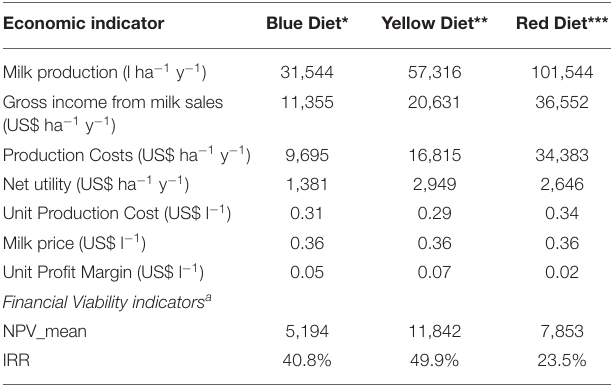
TABLE 4 | Overview of principal economic indicators per